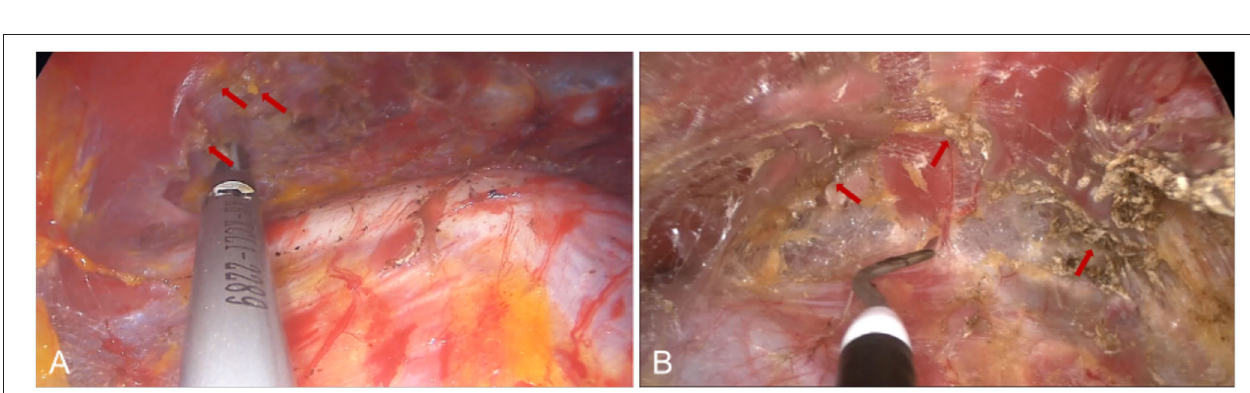
prosthesis placement cavity during the stripping process, which is helpful for accurate stripping of the implanted cavity, protection of nerve function and adequate hemostasis to obtain good breast augmentation shapes and reduce the incidence of postoperative complications. (2) Dual-plane